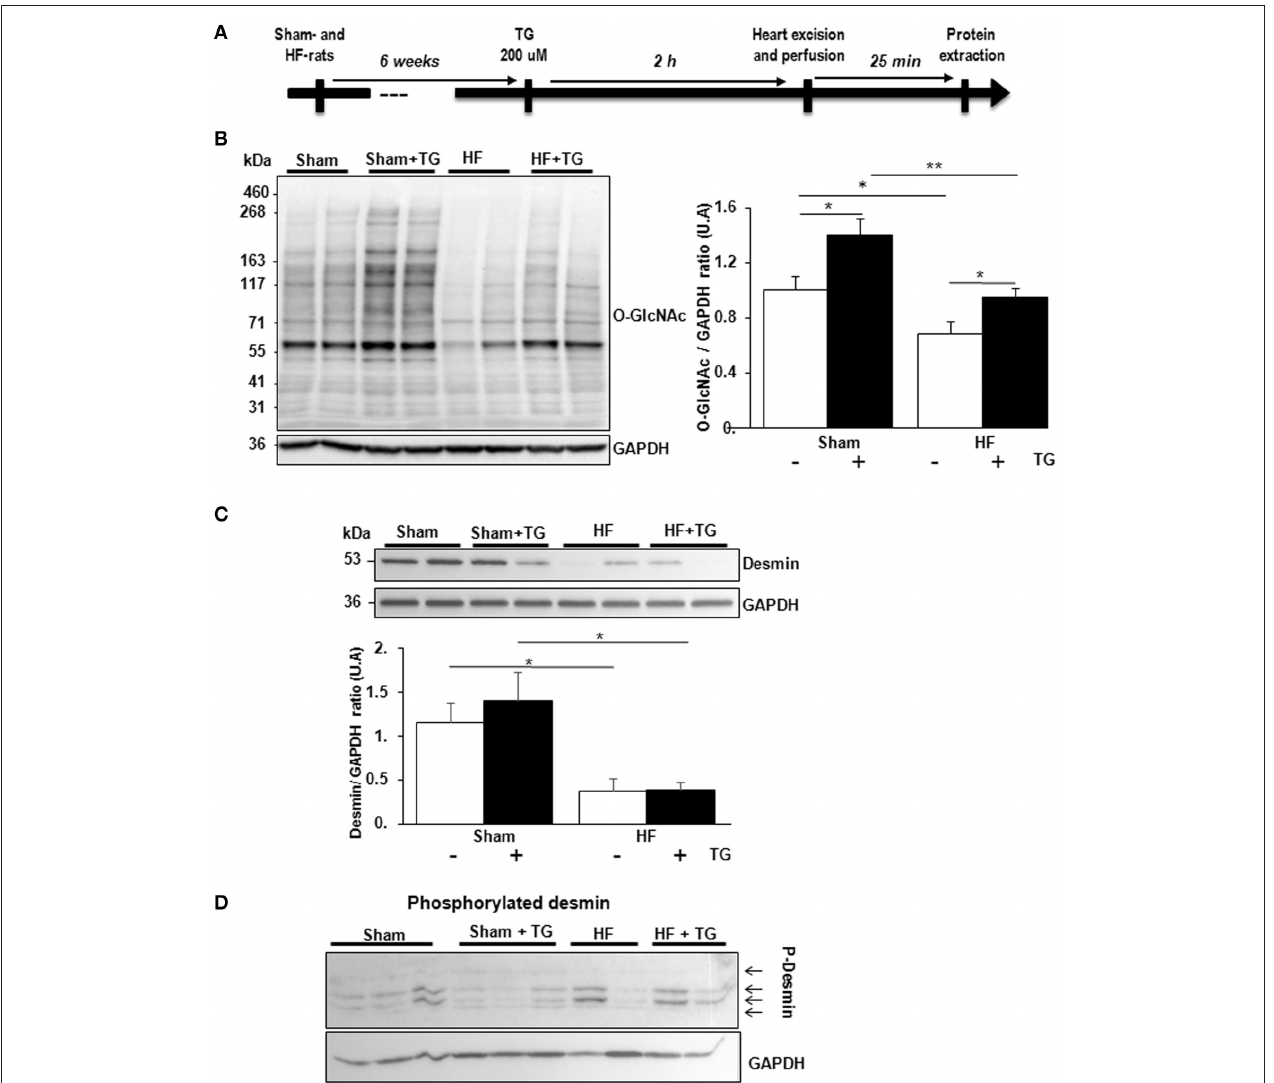
FIGURE 4 | Effect of OGA inhibition by thiamet G in isolated perfused heart. (A) Description of the protocol designed for thiamet G (TG) perfusion in sham- ( n = 6) and HF- ( n = 7) rats 6 weeks post-MI. (B) Western blot (left panel) and quantification (right panel) of O -GlcNAcylated proteins levels measured in proteins extracted from LVs of isolated perfused sham- and HF-rat hearts treated or not with 100 µ M thiamet G for 2h ( n = 7 in each group). (C) Western blots (upper panel) and quantification (lower panel) of total desmin levels in the same samples. (D) Phosphorylation profiles of desmin were analyzed in the same samples by Phos-tag TM gel. Graphs show mean ± SEM values expressed in arbitrary units (A.U.). The positions of molecular weight are indicated as kilodalton (kDa) on the left. * P < 0.05; ** < 0.01.